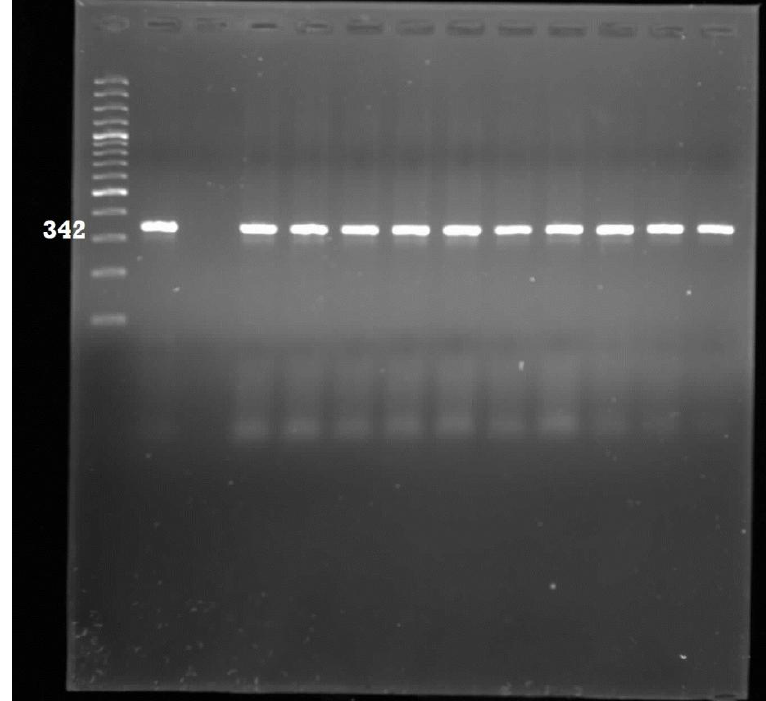
Figure 3. Gel electrophoresis for the detection of Neonatal meningitis E. coli amplicons. Lane 1: 100 bp ladder; Lane 2: Positive control; Lane 3: Negative control; Lane 4–13: Positive samples.